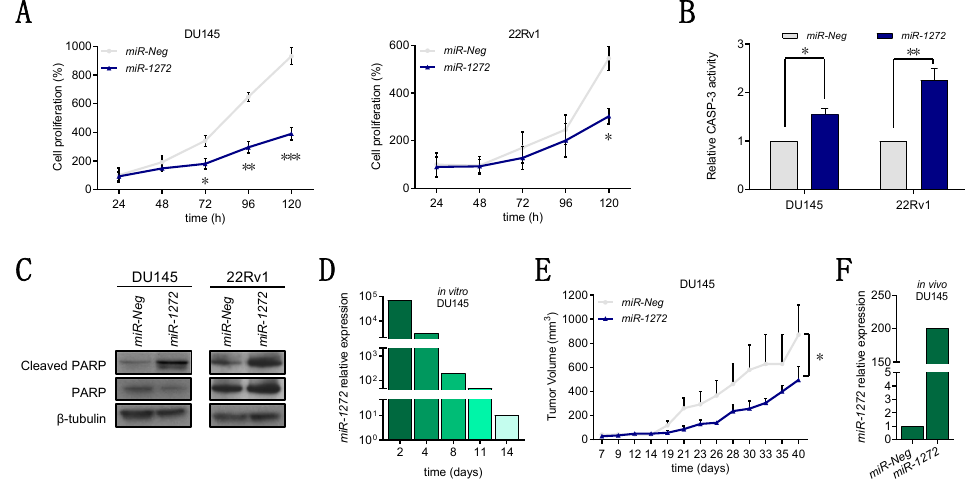
Figure 2. miR-1272 reduces the growth of PCa cell lines both in vitro and in vivo. ( A ) Graphs reporting the growth of miR-Neg and miR-1272 transfected DU145 (top) and 22Rv1 (bottom) cells at different time points after transfection. Data are reported as percentage (mean ± SD as from 3 independent experiments) of cell number in each condition with respect to the number of miR-Neg cells collected at 24 h. ( B ) Bar plots reporting the relative catalytic activity of Caspase-3 (mean + SD from 3 independent experiments), an indicator of apoptosis induction, at 96 h after transfection of DU145 and 22Rv1 cells with miR-Neg and miR-1272 . ( C ) Representative immunoblotting showing protein levels of cleaved and total PARP in miR-Neg and miR-1272 transfected DU145 (left) and 22Rv1 (right) cells. β -tubulin was used as endogenous control. ( D ) RT-qPCR showing relative expression of miR-1272 in miR-1272 transfected DU145 cells with respect to miR-Neg cells, at different time points after transfection. RNU48 was used as endogenous control. ( E ) Graph reporting the tumor growth volume (mean + SD) of xenografts originated from miR-Neg and miR-1272 transfected DU145 cells (10 mice per group), as measured with a Vernier caliper on the indicated days after cell injection into SCID mice. ( F ) RT-qPCR showing relative expression of miR-1272 in xenografts derived from miR-1272 transfected DU145 cells as compared to those derived from miR-Neg cells, at 23 days after injection into SCID mice. RNU48 was used as endogenous control. * p < 0.05, ** p < 0.01, *** p < 0.001, Student’s t -test.